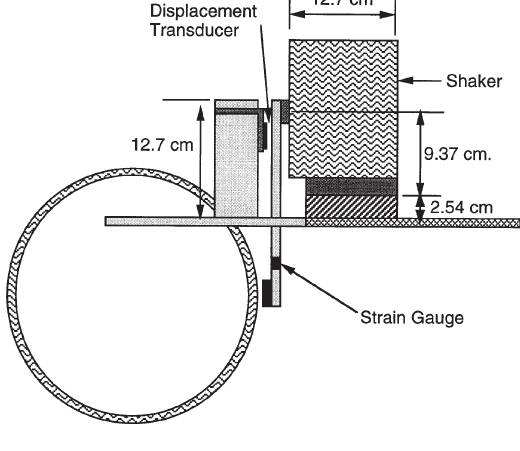
Fig. 1. Schematic diagram of test